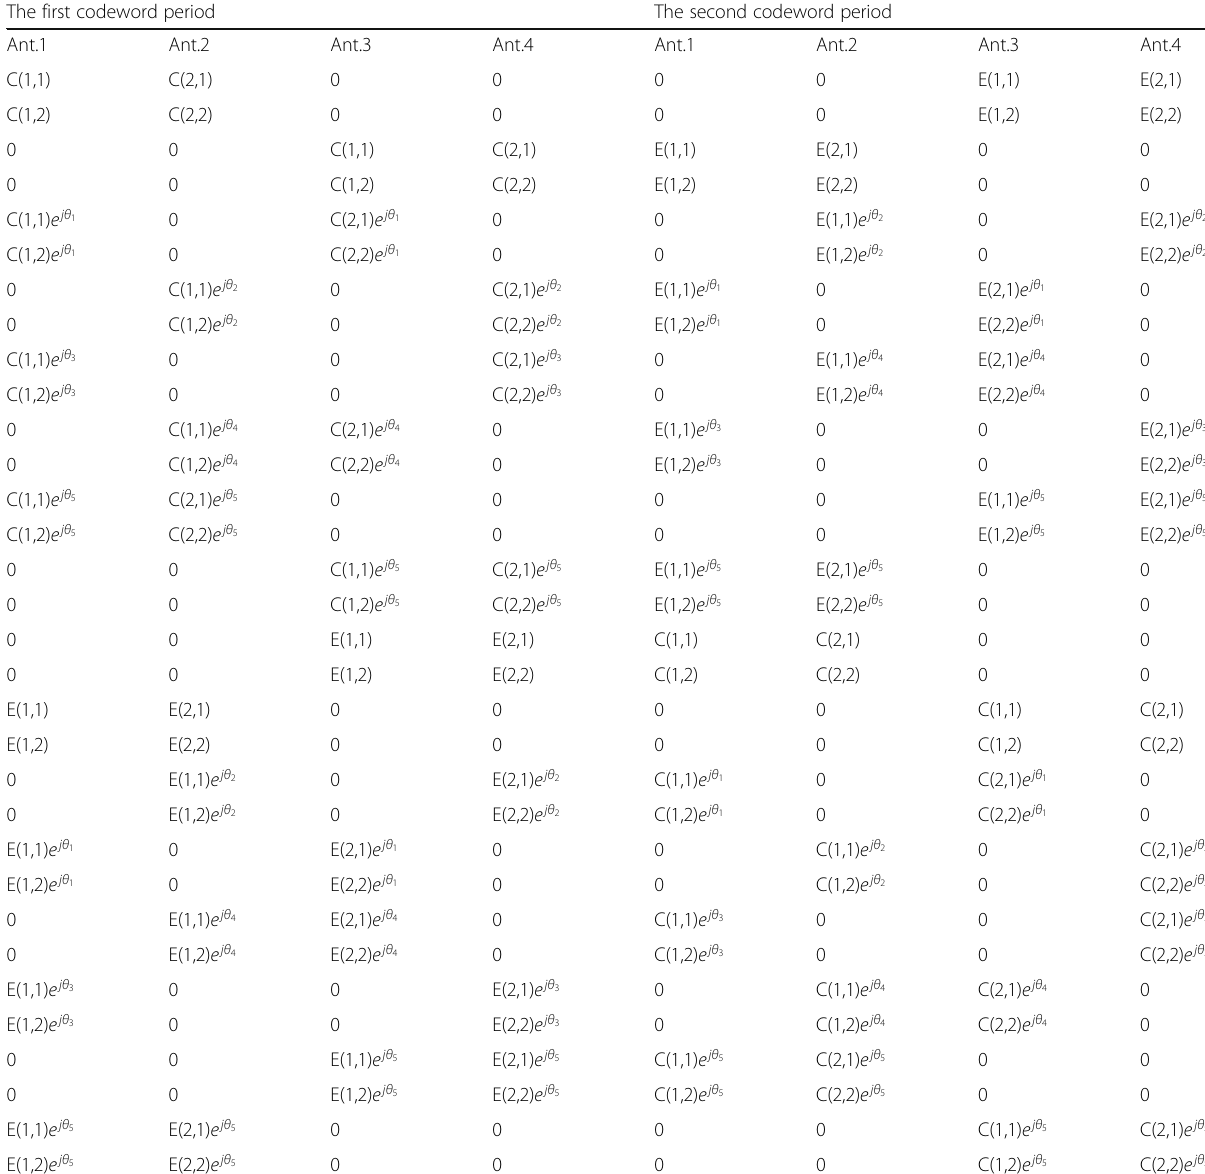
Table 2 The transmission and encoding of the proposed L-SM scheme with N all = 4, N t = 2, and (1 + 2log 2 M ) bits/s/Hz The first codeword